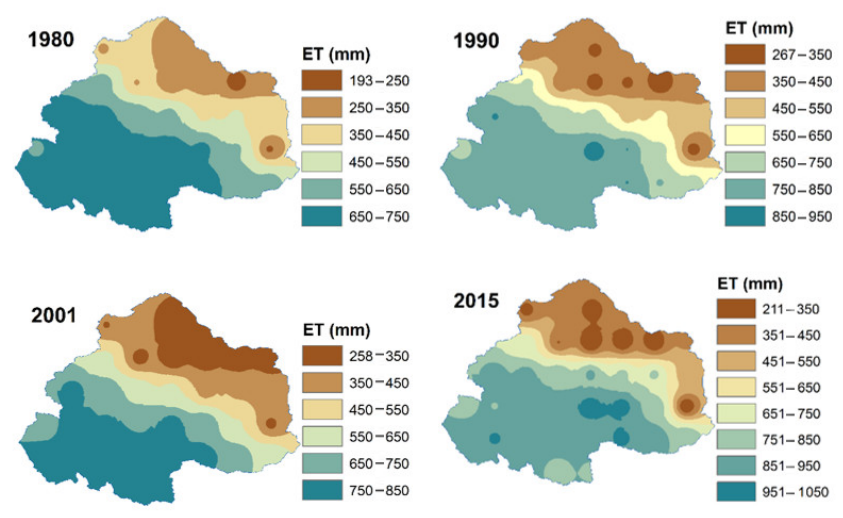
Figure 8. Spatial distribution of AET obtained from GLDAS Noah output